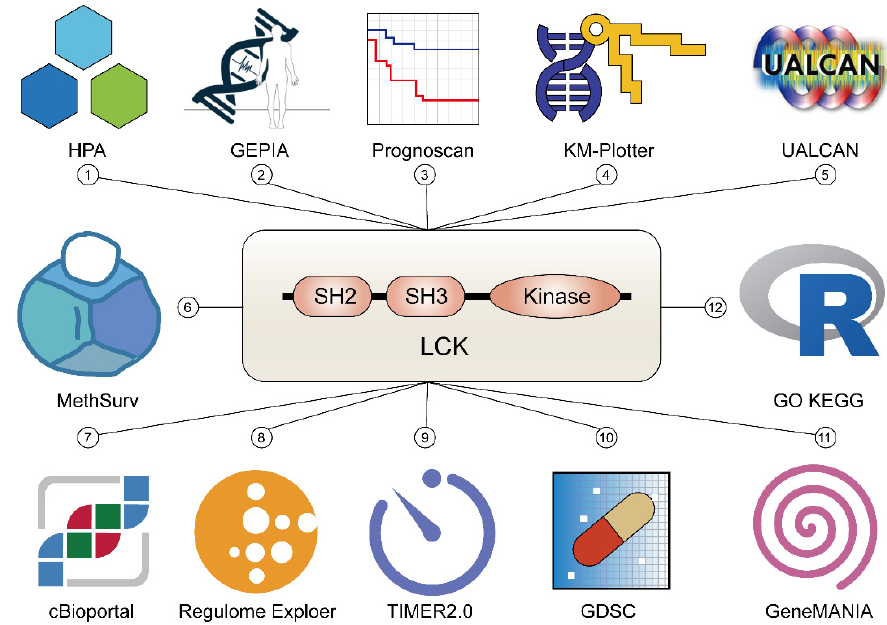
Figure 1. The schematic diagram shows the main databases and tools used in this